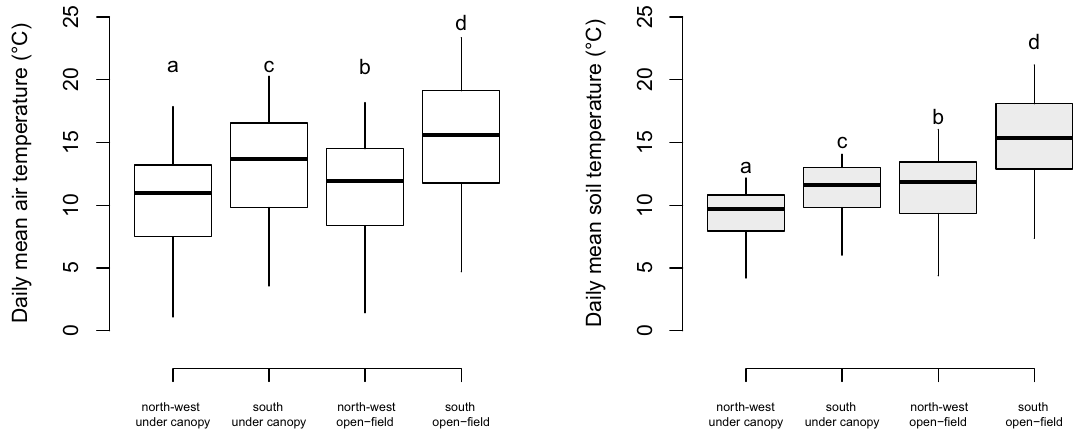
Figure 2. Temperatures categorized by their position at the treeline. Daily mean air (left) and soil (right) temperature for the growing season (from May to September). Each box shows the 75th to 25th percentiles, and the line inside represents the median; upper and lower marks are the largest to smallest observation values, which are less than or equal to the upper and lower quartile plus 1.5 times the length of the interquartile range; circles outside the lower–upper mark range are outliers. Different letters indicate significant differences for P <